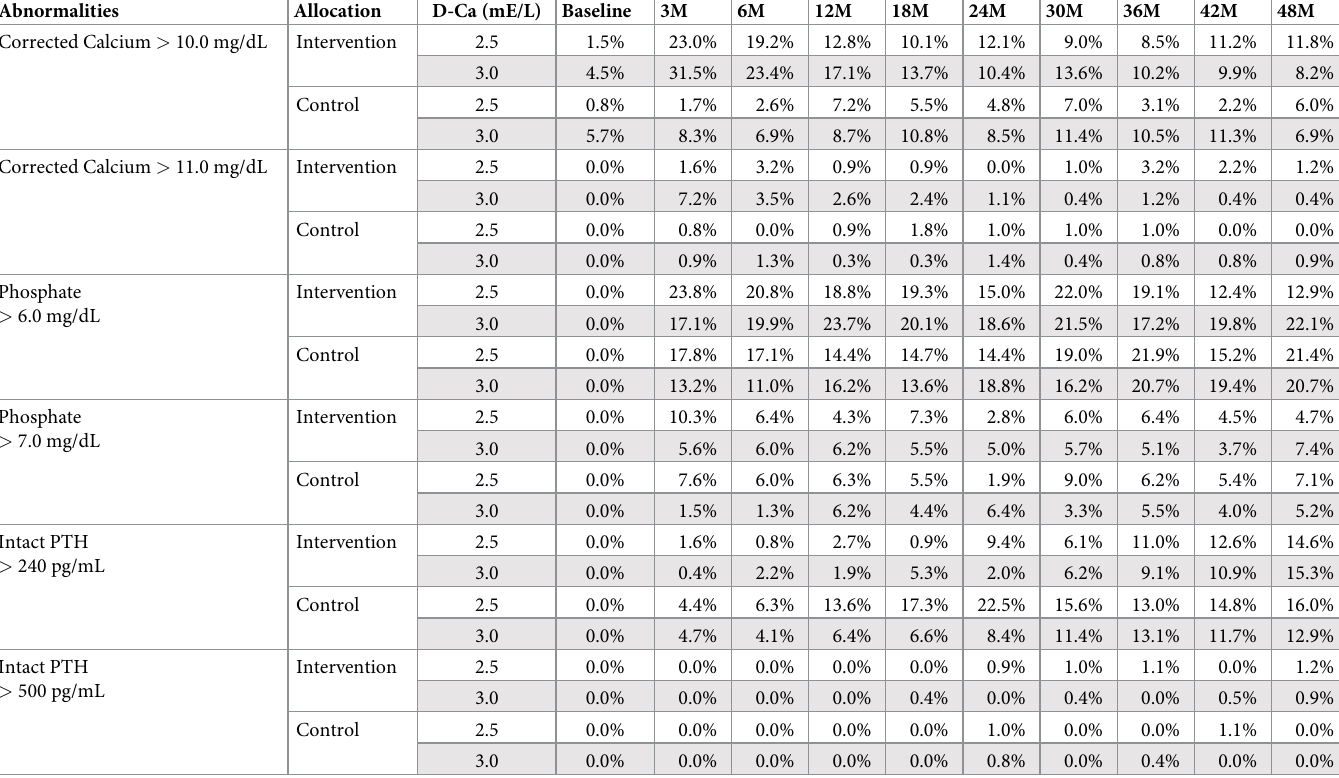
Table 1. Prevalence of laboratory abnormalities by allocation and dialysate calcium concentration at each study month.